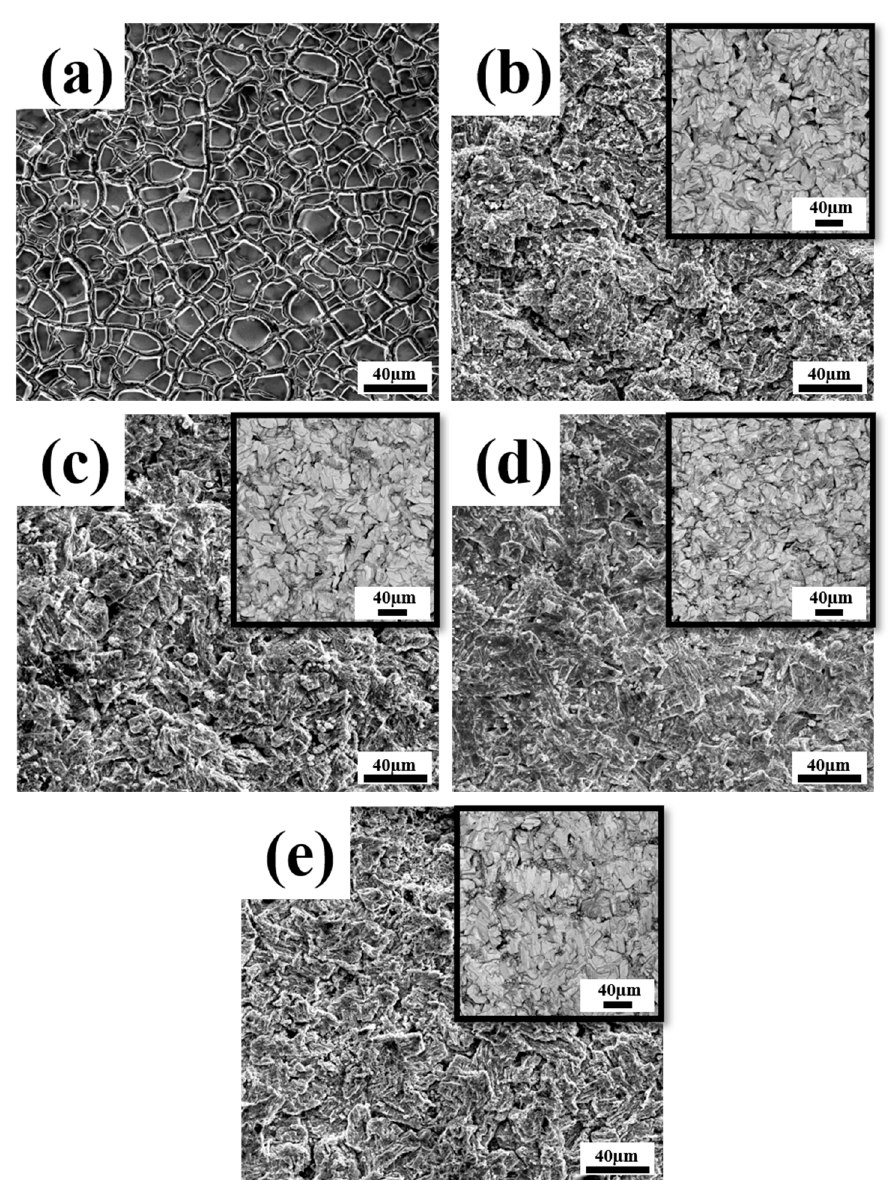
Figure 2. The surface morphologies of ( a ) Ti/SnO 2 -Sb 2 O x made by traditional dip-coating, and Ti/SnO 2 -Sb 2 O x -TiO 2 electrodeposited with different additions of TiO 2 sol: ( b ) 0 mL/L ( c ) 5 mL/L, ( d ) 10 mL/L, and ( e ) 15 mL/L (insets are the corresponding Sn-Sb-TiO 2 coatings before the heat treatment process).